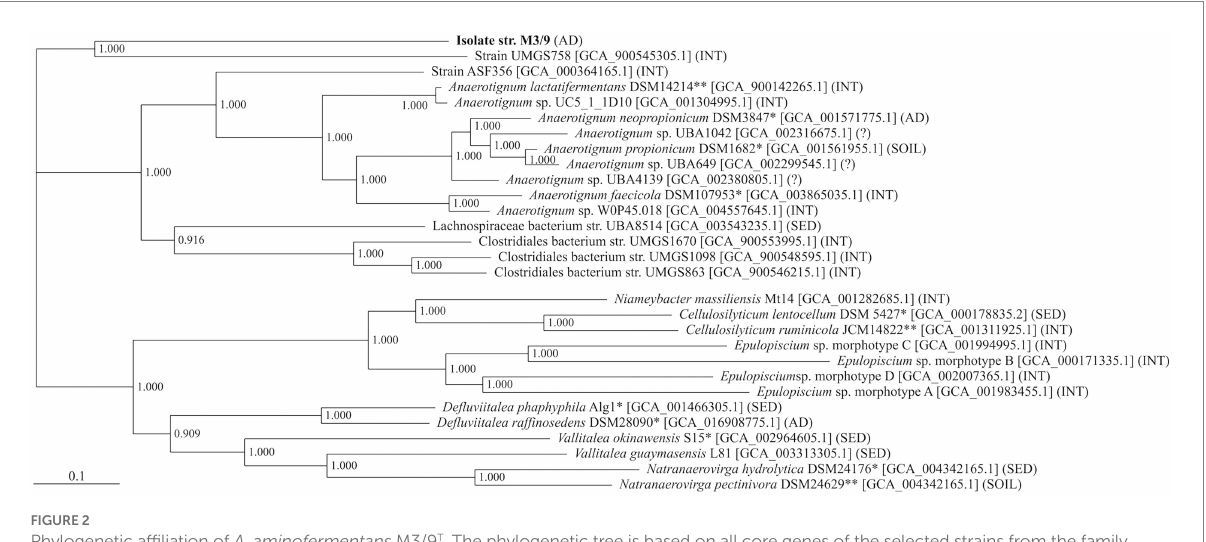
FIGURE 2 Phylogenetic affiliation of A. aminofermentans M3/9 T . The phylogenetic tree is based on all core genes of the selected strains from the family Lachnospiraceae as determined by means of the comparative genomics tool EDGAR. The bar below the phylogenetic tree represents the scale of sequence divergence. Sampling site: AD, anaerobic digester; INT, intestinal microbiome; SED, marine or freshwater sediment; SOIL, soil;?, unknown sampling site. * , species type strain; ** , genus type